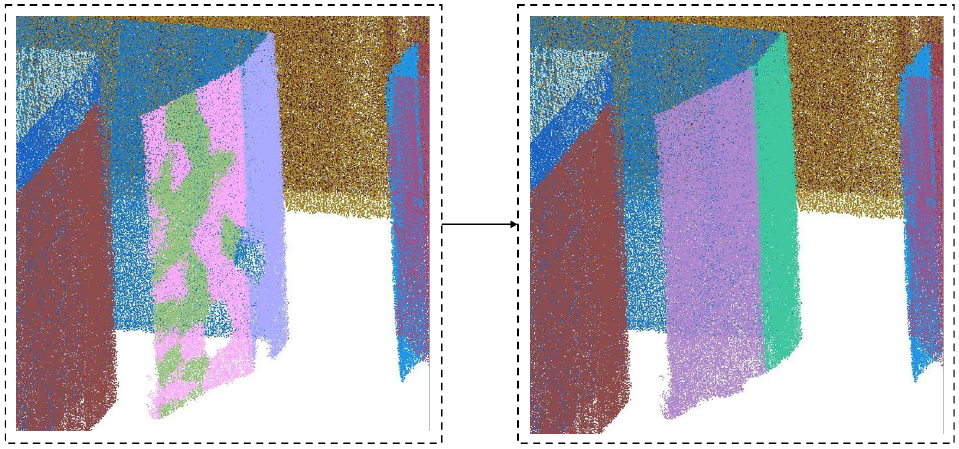
Figure 8. An example of the effectiveness of energy optimization.